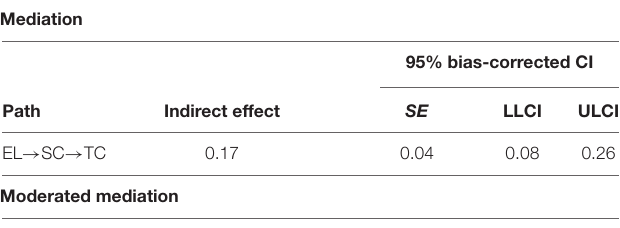
TABLE 5 | Bootstrapping estimates for mediation and moderated mediation.